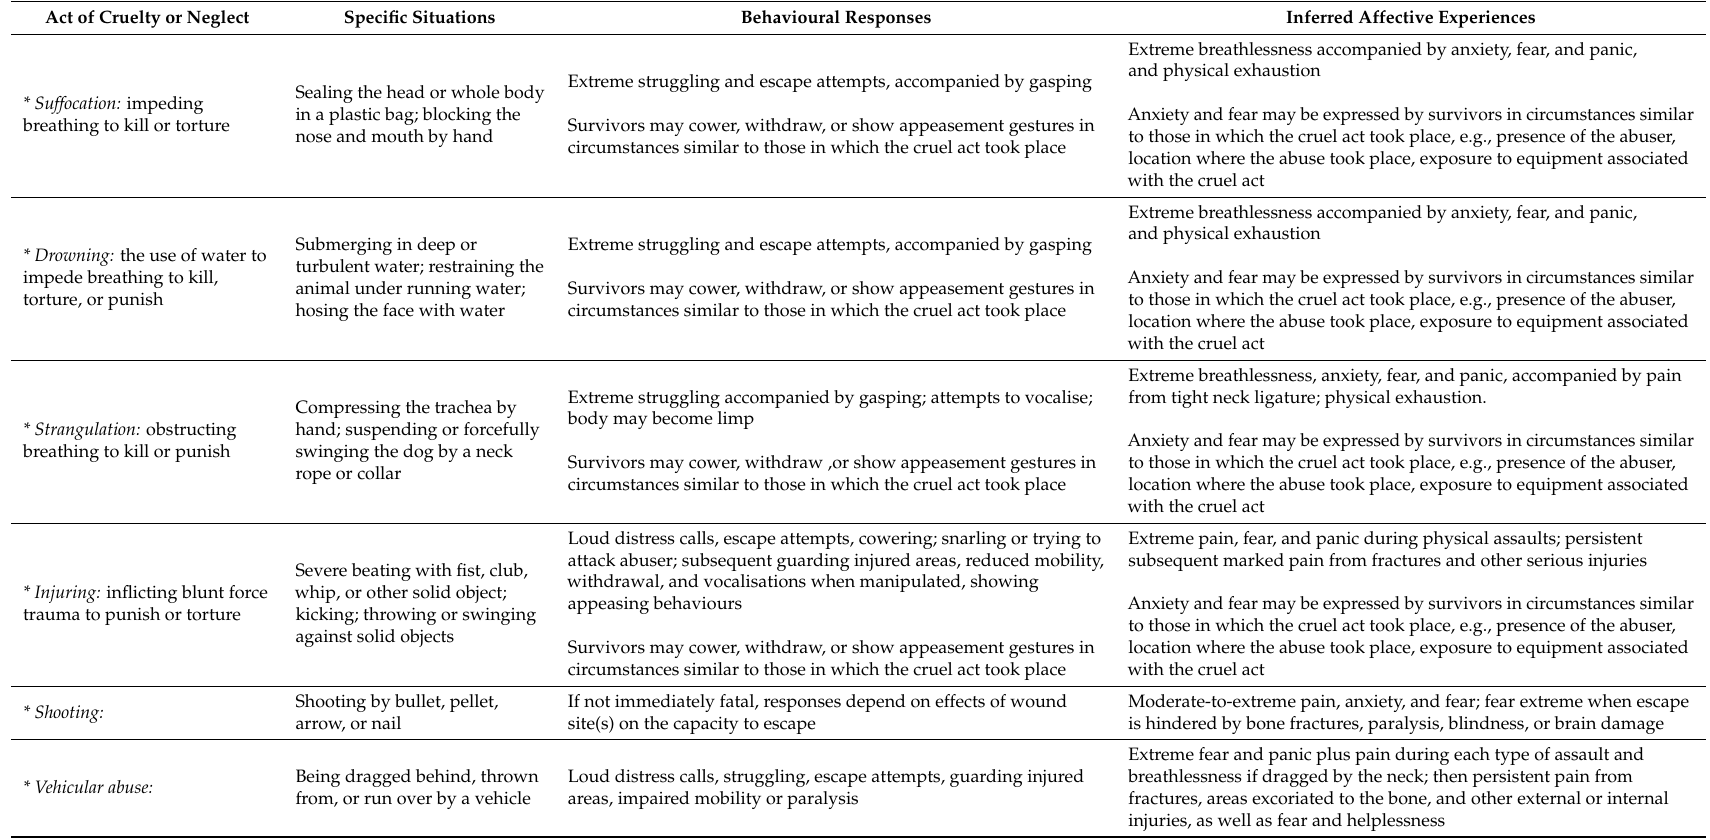
Table 2. Examples of cruelty and neglect towards dogs. The description of each act of cruelty includes brief examples of specific situations, the likely behavioural responses, and the negative affective experiences inferred from the situation and/or behavioural responses. See Table 1 for a brief description of each affective experience. Note that when all the examples provided are judged on a 5-tier scale of “none”, “minor”, “moderate”, “severe”, and “very severe” acts of cruelty or neglect [49], the majority fall into the severe-to-very severe categories, where the occurrence of negative affects would not be in doubt. * denotes situations that may result in